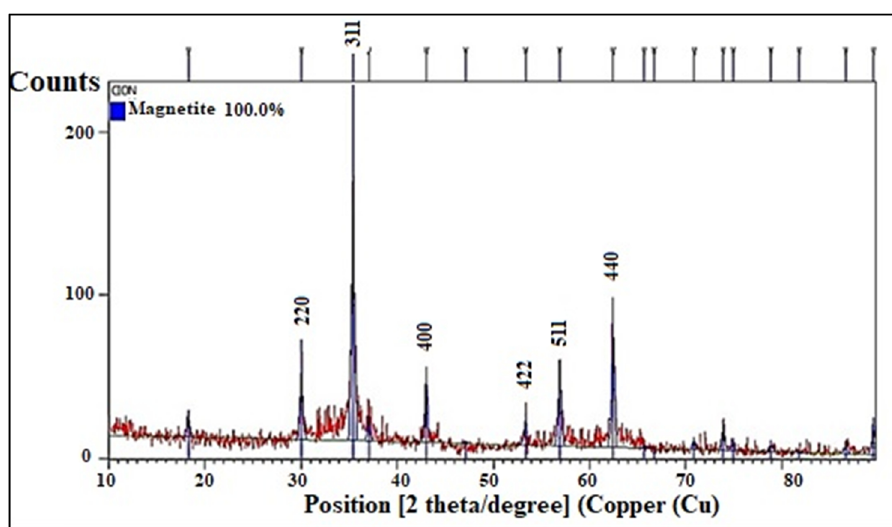
Figure 3: XRD pattern of green - synthesized IONPs.